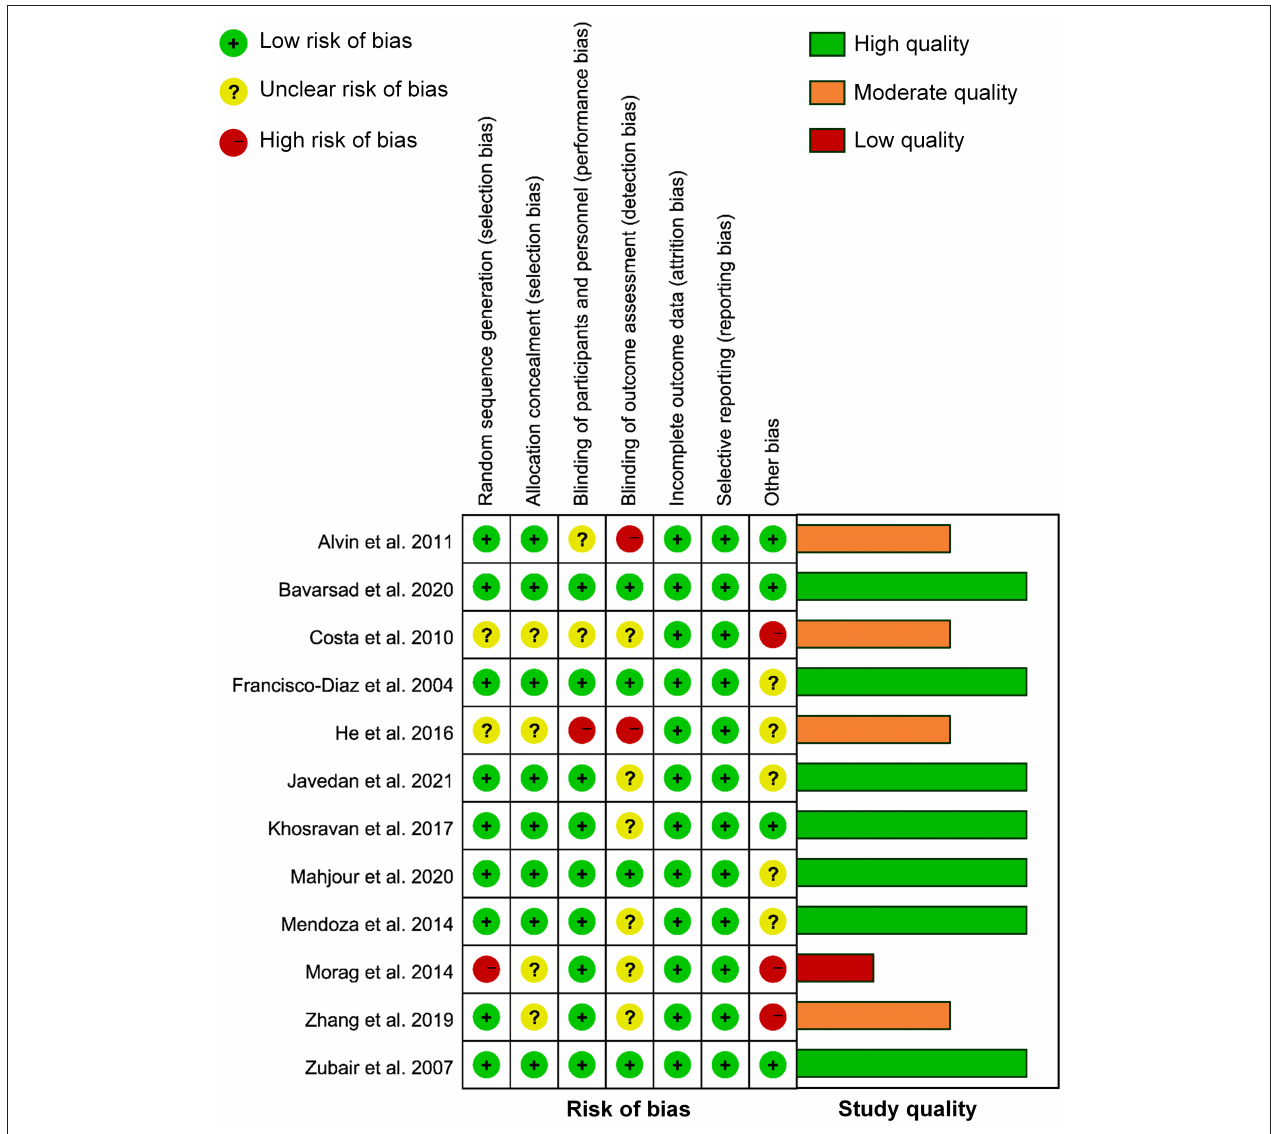
FIGURE 2 | Risk of bias and study quality assessment of included randomized controlled trials